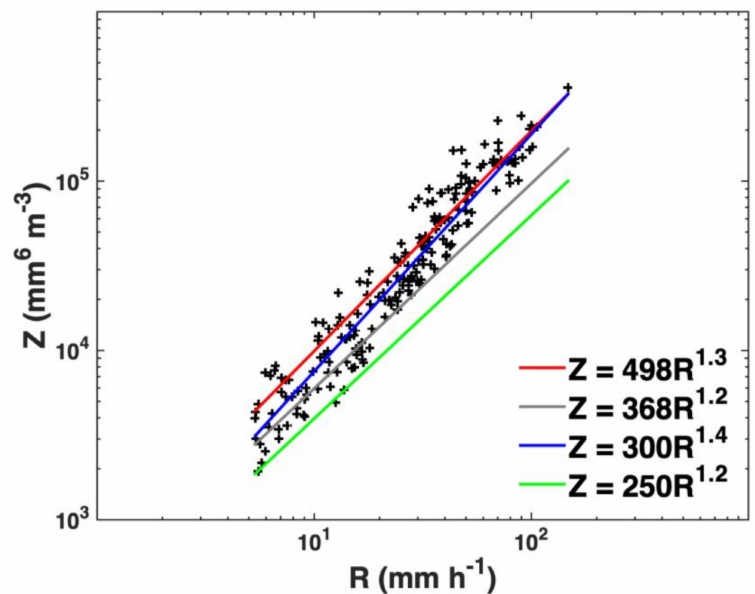
Figure 9. Scatter plot of Z versus R for convective rain observed from the filtered data only for the total drop counts > 1000. The fitted power law relationship in the form of Z = AR b using a least-squares method are shown in red line. The gray line stands for the Meiyu Z–R relationship in eastern China ( Z = 368 R 1.2 ), the blue line represents the standard NEXRAD Z–R relationship ( Z = 300 R 1.4 ), and the green line is the tropical Z–R relationship ( Z = 250 R 1.2